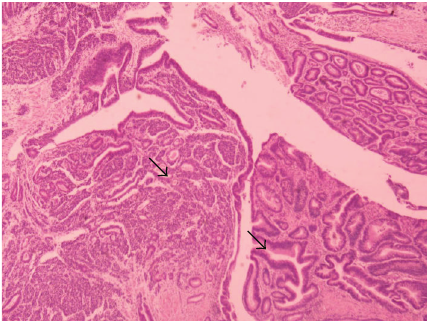
Figure 4: The tumor from the inside.